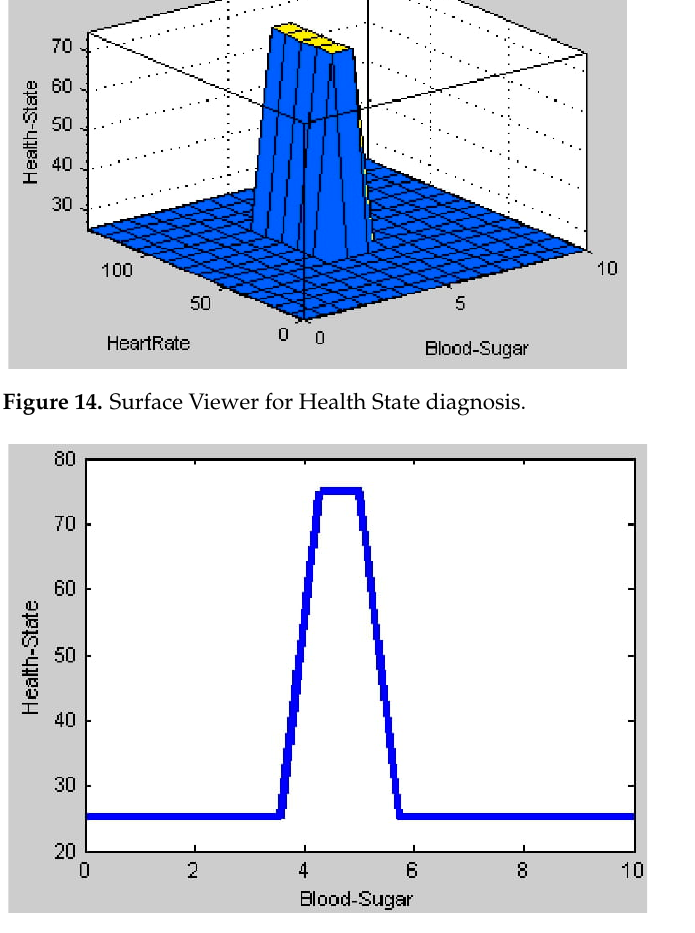
Figure 13. Output Plot. Figure 14. Surface Viewer for Health State diagnosis.